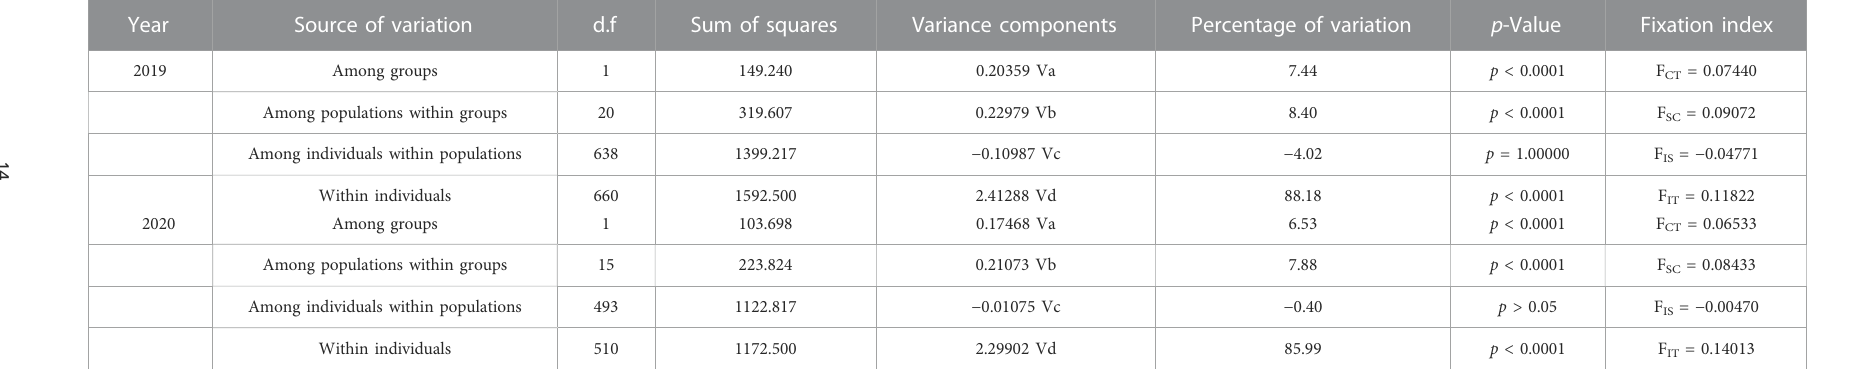
TABLE 6 Results of AMOVA in 2019 and